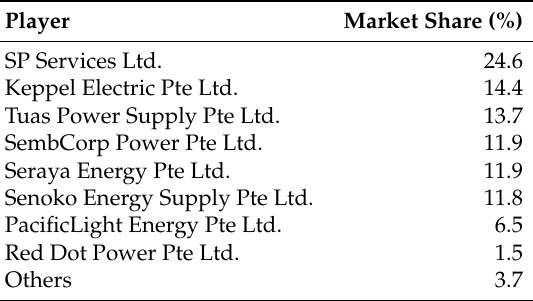
Table 6. Retailers’ market share in the Singapore.